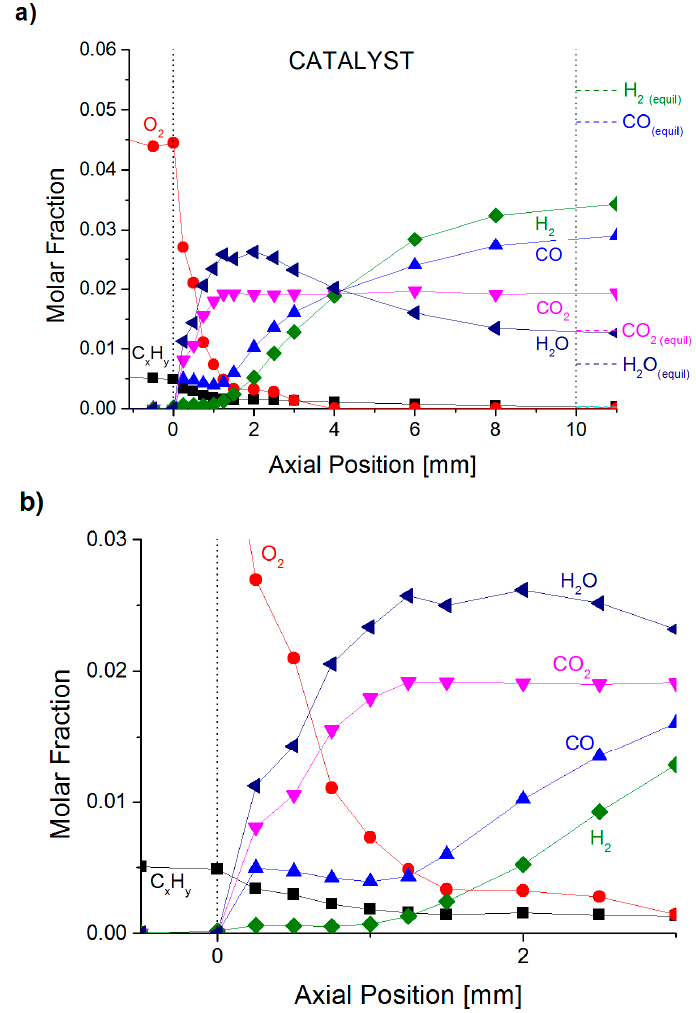
Figure 1. ( a ) Molar fraction of reactants and products as function of the axial coordinate z for the catalytic partial oxidation (CPOX) of the fuel “Su 17”. Su 17 contains 83 vol % n ‐ dodecane and 17 vol % 1,2,4 ‐ trimethylbenzene. The axial section of − 1 mm < z < 11 mm is chosen in order to improve the visibility of the molar fractions inside the catalyst ( z = 0–10 mm). Dashed lines represent thermodynamic equilibrium values; ( b ) zoomed version of ( a ) within the oxidation zone and the oxy ‐ reforming zone ( − 0.5 mm < z < 3 mm).